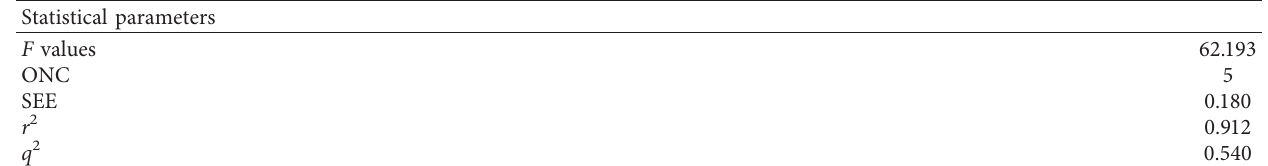
Figure 1: (a) Molecular structure of the aminomethylenethiophene derivatives. (b) The splitting mode for the topomer CoMFA modelling (using compound 22 as the reference). Table 2: Statistical results of the topomer CoMFA model.